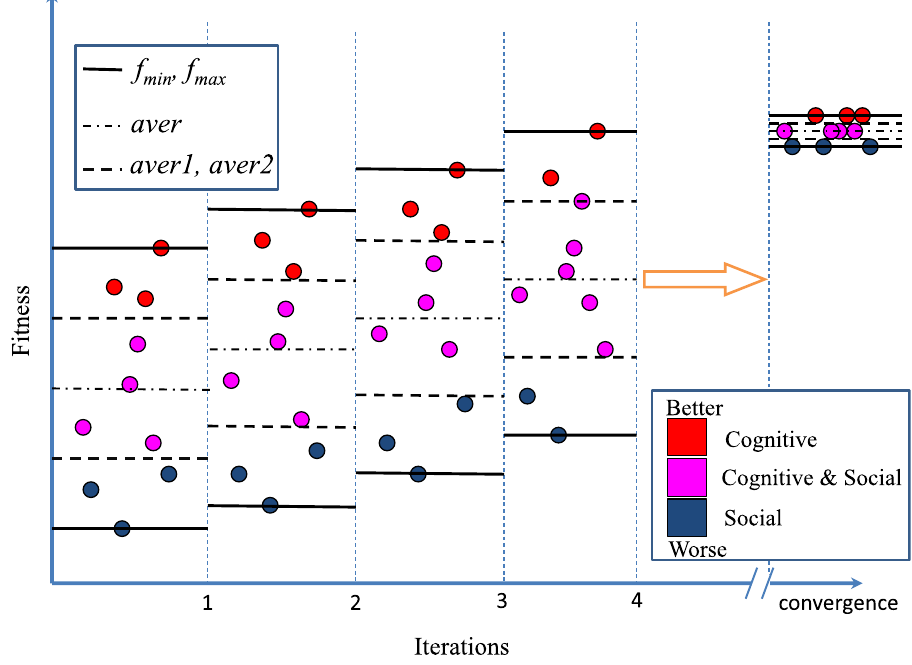
Fig. 1 Particles’ evolution and classification with evolving iterations using